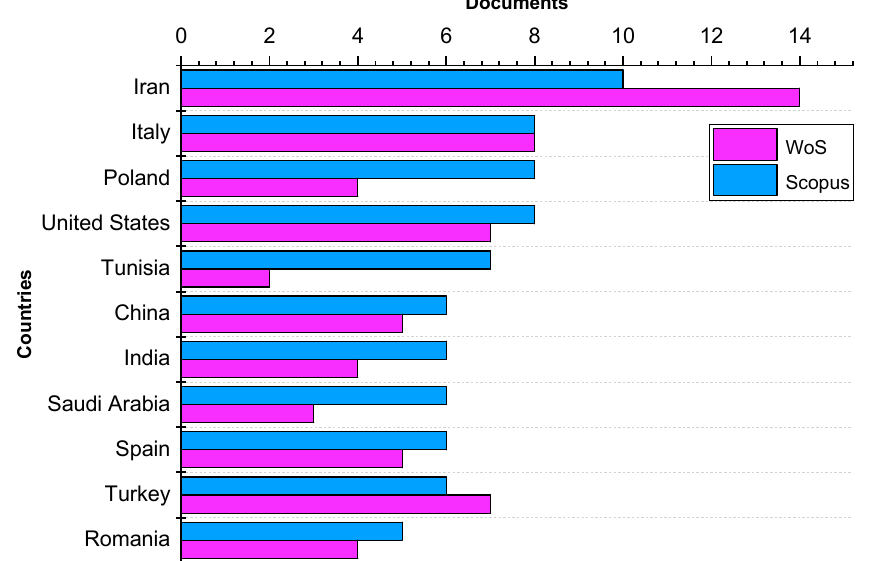
Figure 5. Most productive countries (according to WoS and scopus data).